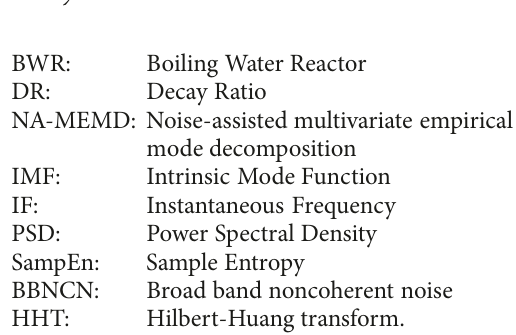
Figure 31: Mean(SampEn) values for the 36 LPRMs of level 4 of the Ringhals BWR